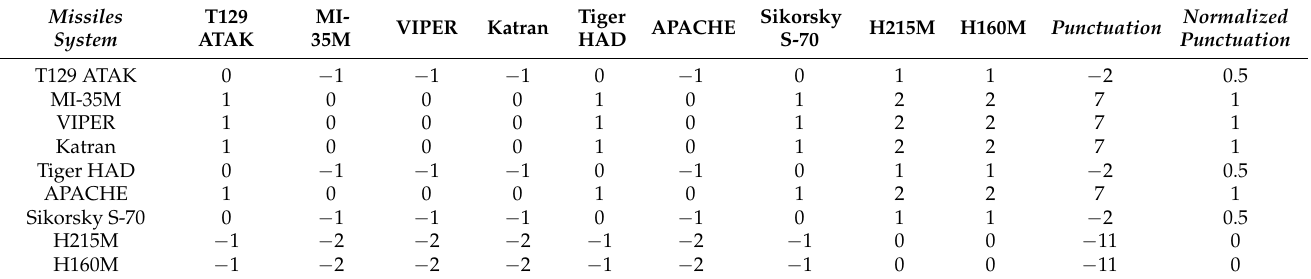
Table 7. Evaluation of alternatives under qualitative criterion Missiles system .